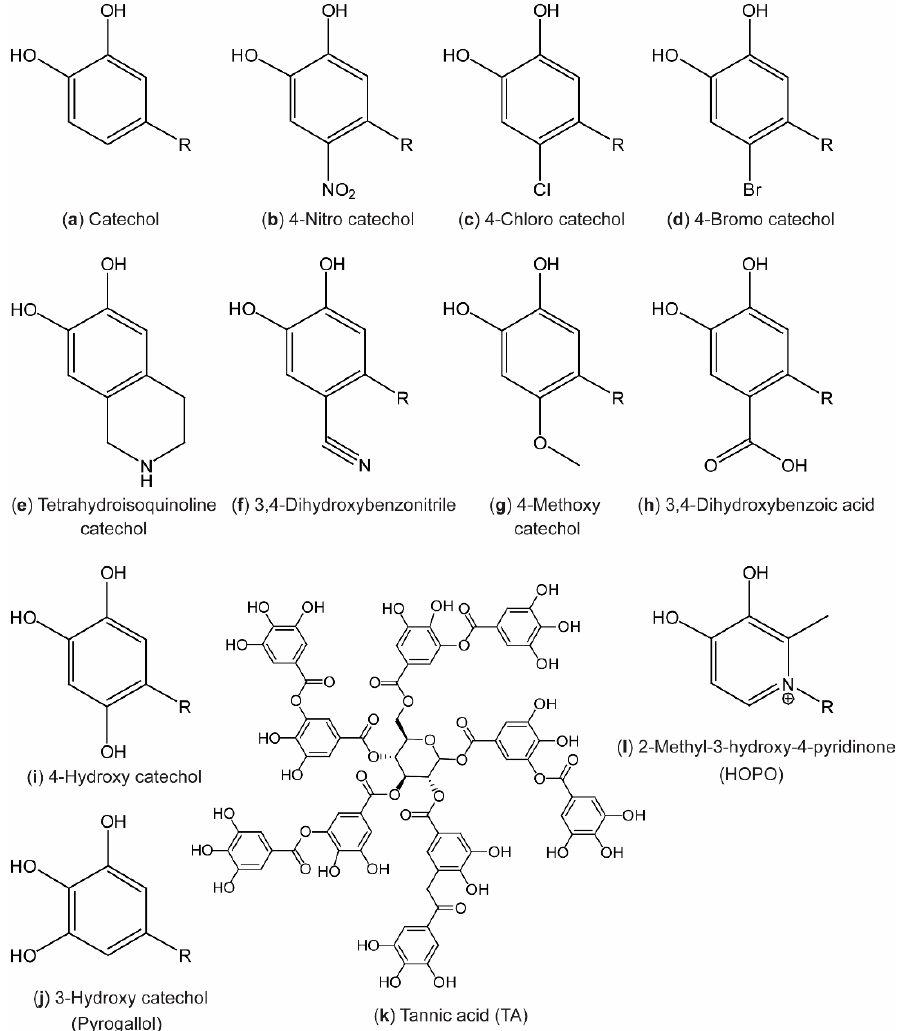
Figure 1. Coordination geometry of the tris(catecholato)Fe(III) complex from the crystal structure of